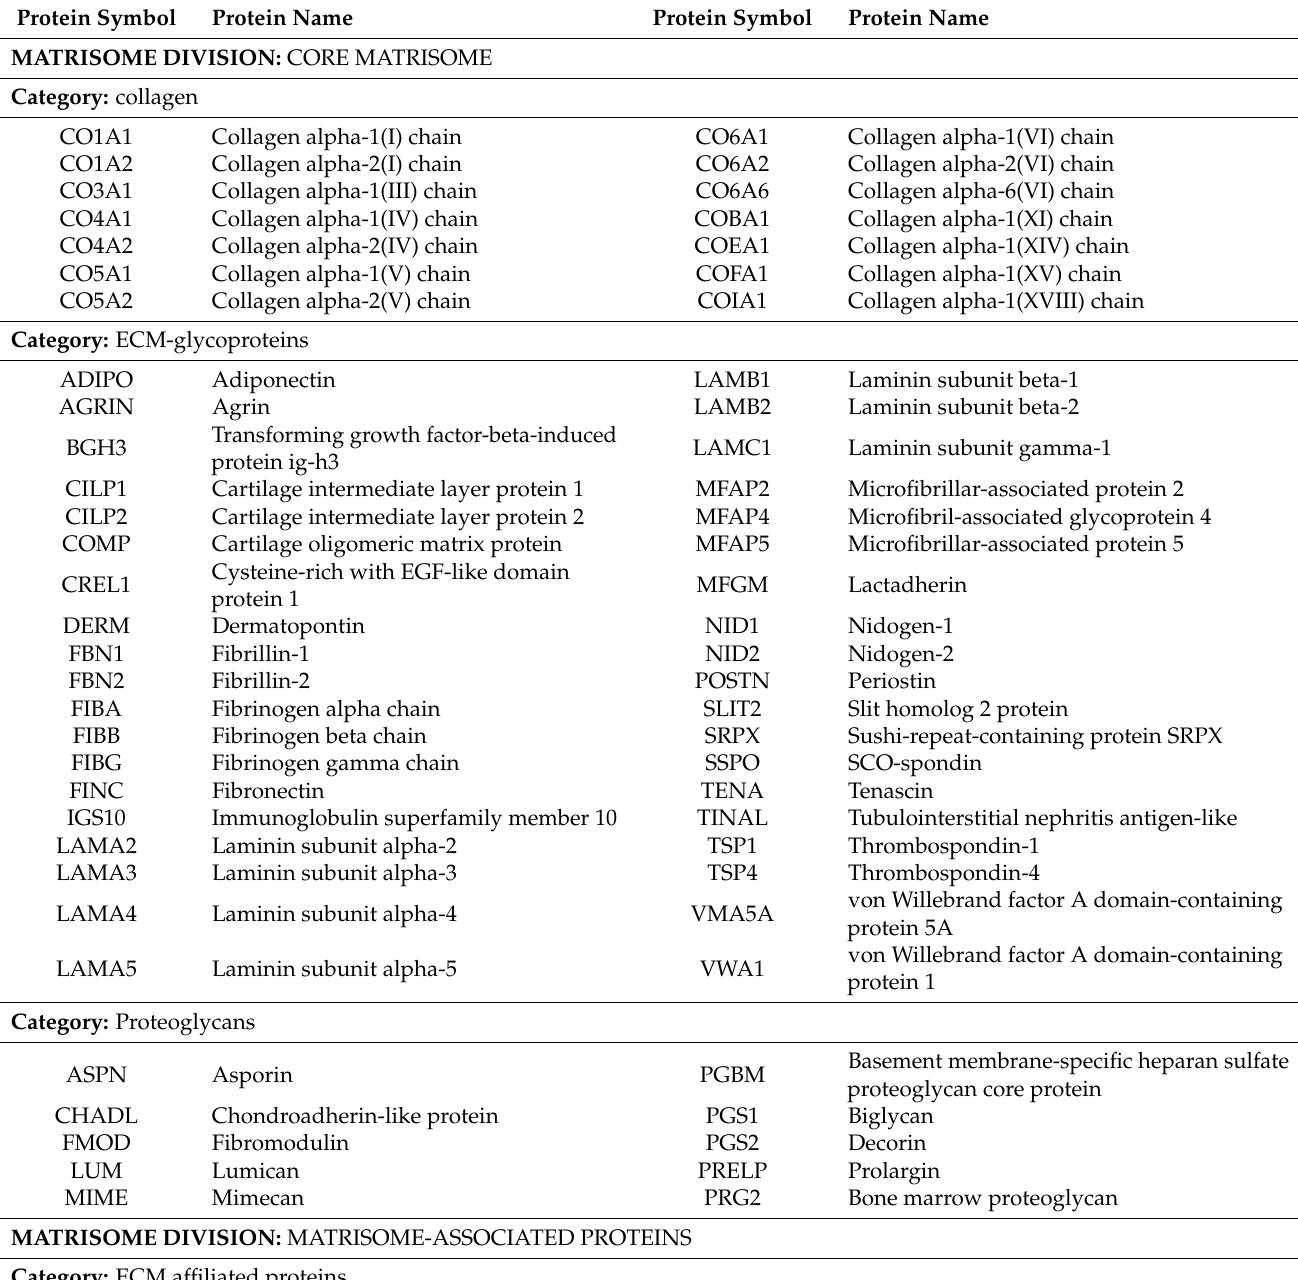
Table 1. ECM and ECM-associated components from the gastrocnemius muscle categorized according to MatrisomeDB. Protein Symbol Protein Name Protein Symbol Protein